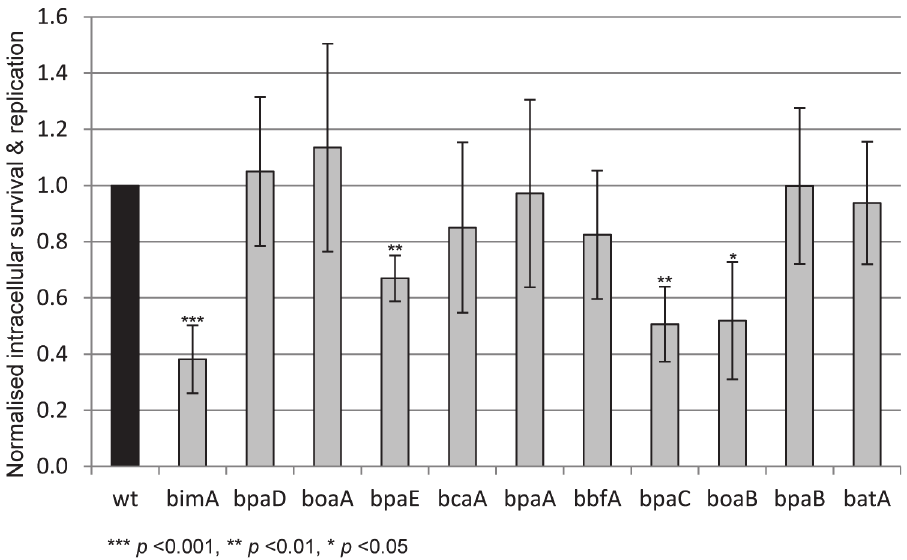
Fig 1. Net intracellular replication of the B . pseudomallei AT mutants in J774.2 macrophage-like cells. Viable intracellular bacteria were enumerated (output divided by input CFU) for the duplicate experimental samples of each of the AT mutants and the data was normalised against the wild-type parent strain. Data from five experiments was expressed as the mean and standard error of the mean; statistical significance was analysed using Student ’ s t